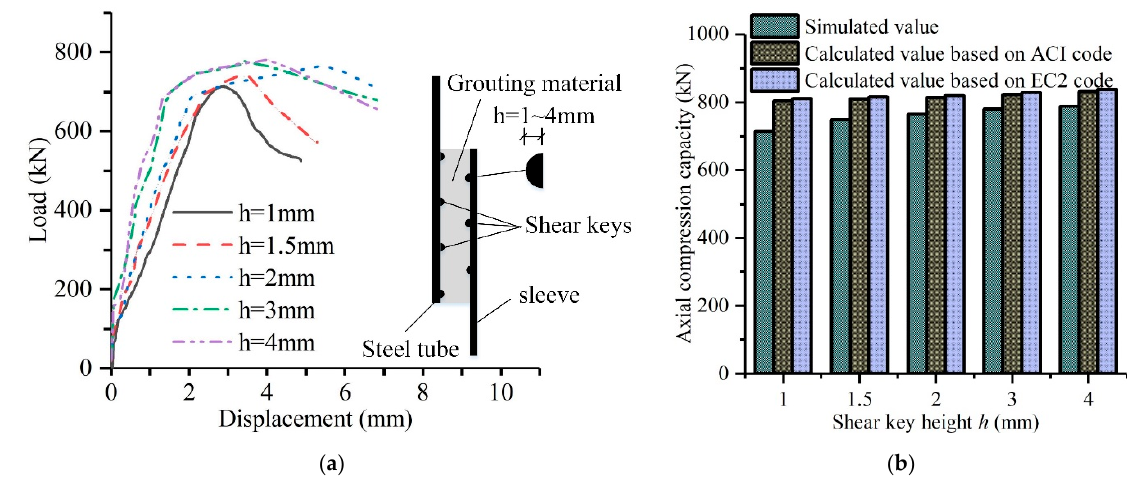
Figure 14. Different shear key heights: ( a ) comparison of load–displacement curves for different shear key heights; ( b ) comparison of calculated and simulated values of different shear key heights.